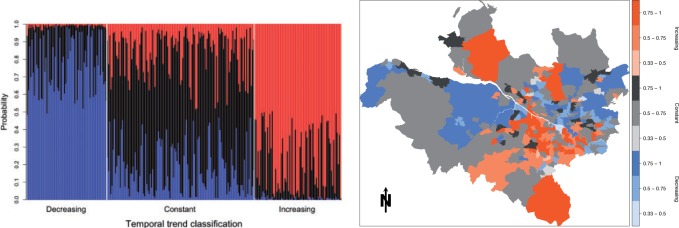
The left panel shows the posterior probabilities that each area (given on \documentclass[12pt]{minimal}
\usepackage{amsmath}
\usepackage{wasysym} 
\usepackage{amsfonts} 
\usepackage{amssymb} 
\usepackage{amsbsy}
\usepackage{upgreek}
\usepackage{mathrsfs}
\setlength{\oddsidemargin}{-69pt}
\begin{document}
}{}$x$\end{document}-axis) is assigned to each trend, while the right panel shows the classification based on the maximum a posteriori probabilities. For the latter, the darker the shading the higher the posterior probability for that trend. All results are from the model with a spline trend with \documentclass[12pt]{minimal}
\usepackage{amsmath}
\usepackage{wasysym} 
\usepackage{amsfonts} 
\usepackage{amssymb} 
\usepackage{amsbsy}
\usepackage{upgreek}
\usepackage{mathrsfs}
\setlength{\oddsidemargin}{-69pt}
\begin{document}
}{}$q=2$\end{document} knots.